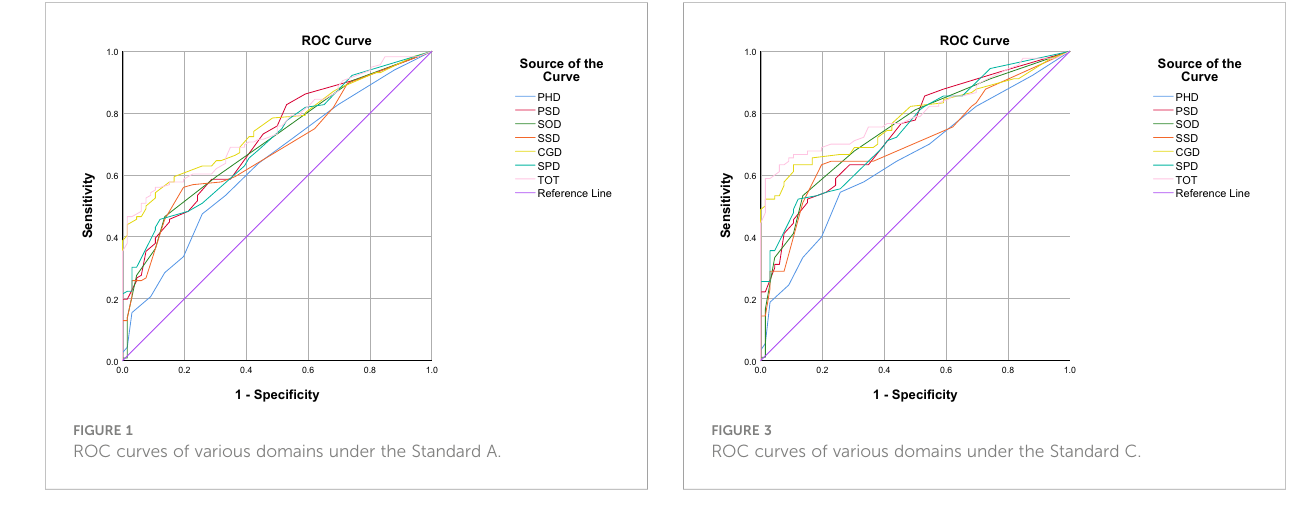
FIGURE 1 ROC curves of various domains under the Standard A.